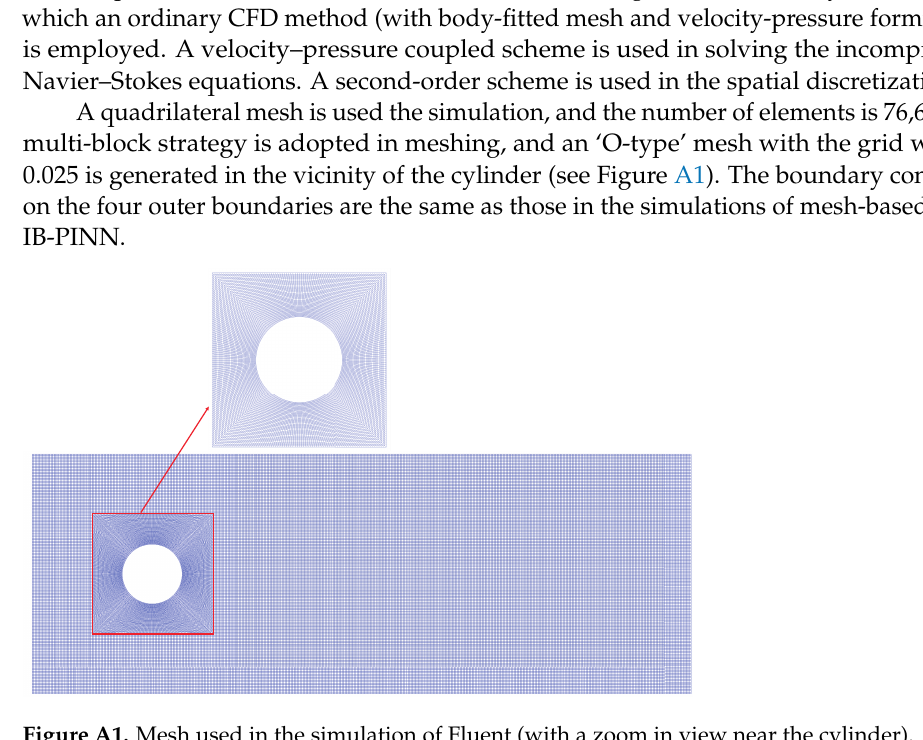
Figure A1. Mesh used in the simulation of Fluent (with a zoom in view near the